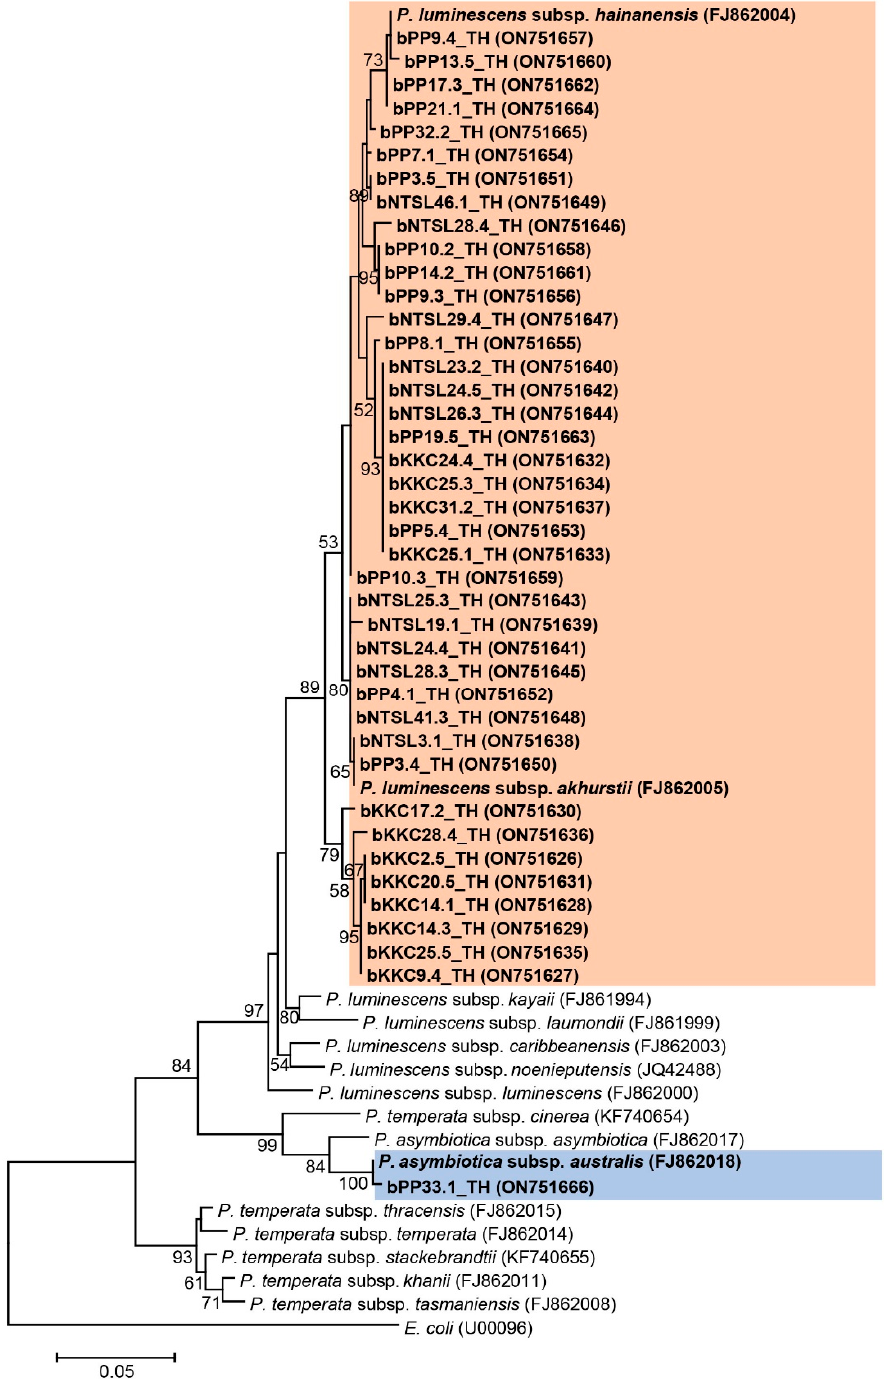
Figure 4. Maximum likelihood tree constructed based on a partial sequence of recA gene (588 bp) of Photorhabdus